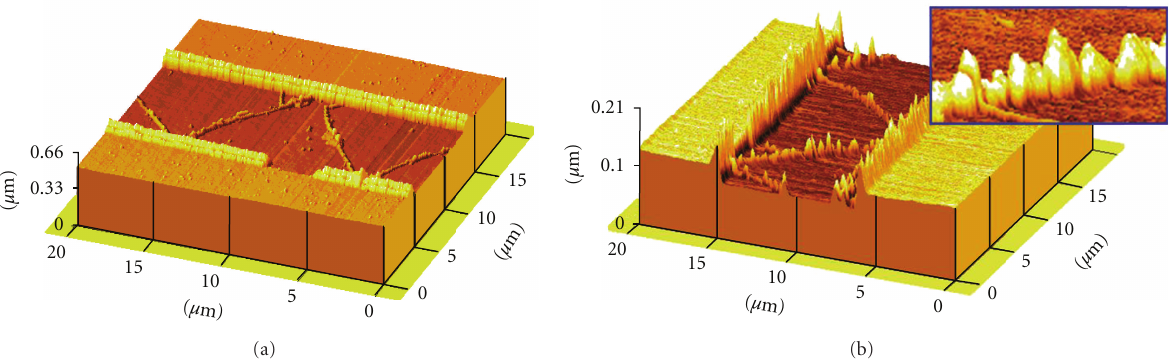
Figure 5: AFM Image of zig-zag-oriented (a) Ti nanowire and (b) Pd nanowire. The inset in (b) illustrates grainy features of the nanowires. Note that the z -scale is drastically overemphasized.